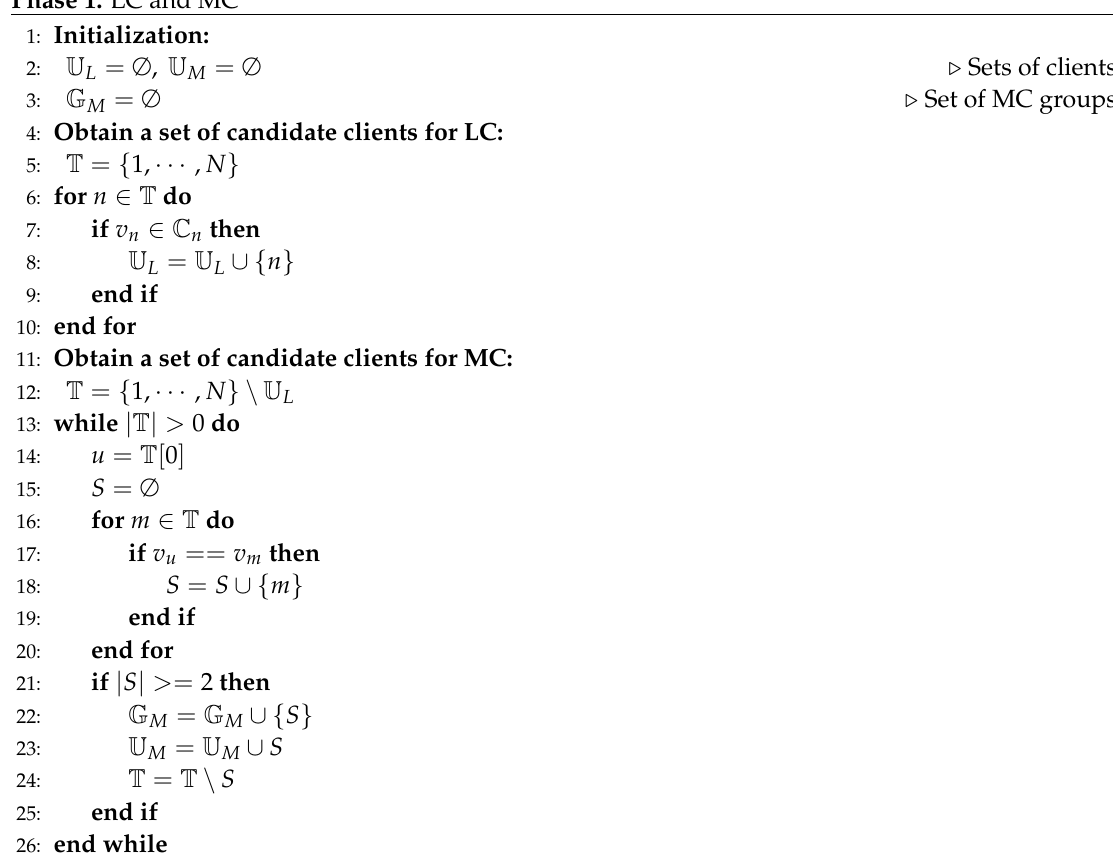
Algorithm 1 Proposed Video Streaming: Phase 1. LC and